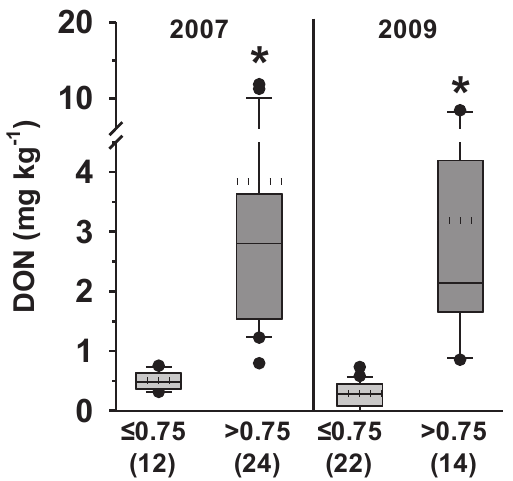
Fig. 2: DON contamination of flour Type 550 in 2007 and 2009 grouped into fulfilling (≤0.75) and exceeding (>0.75) EU maximum level of DON (mg kg -1 ) for flour. In breaks − number of samples per group. Significant difference between groups within year is indicated through * (p<0.001). Box plots show 25-75% percentile, median (solid line), and mean (dotted line).